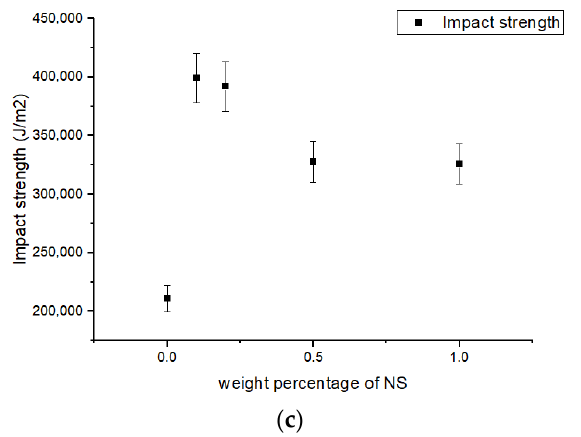
Figure 8. Impact energy stored under Izod impact test of modified GFRP samples with different weight percentages of ( a ) MWCNTs, ( b ) NFe, and ( c ) NS.